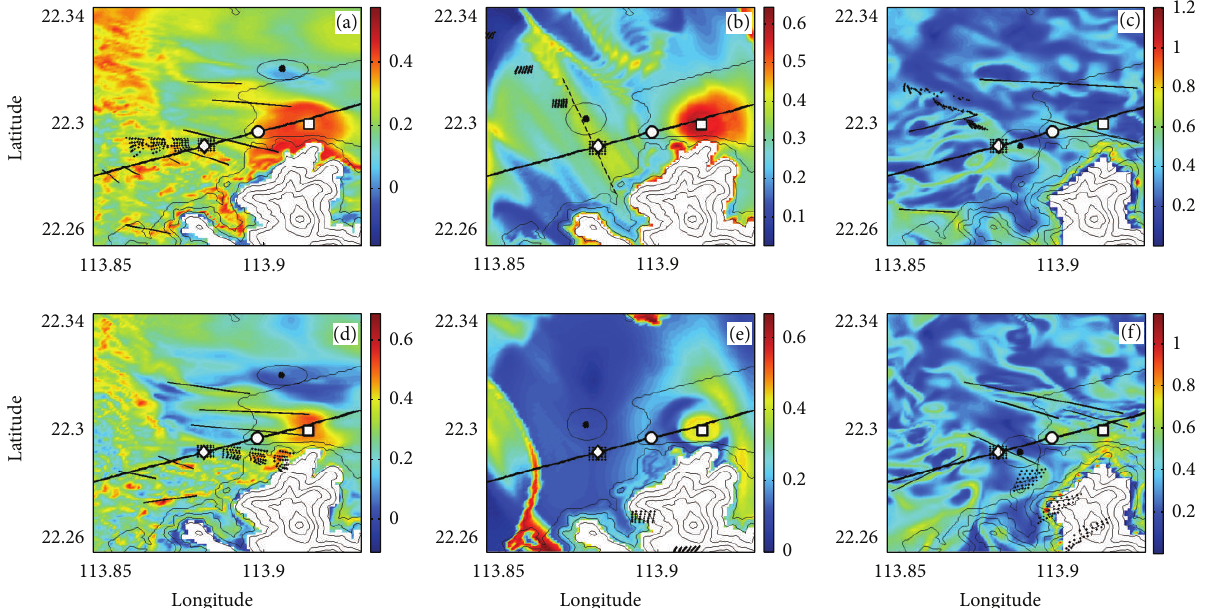
Figure 3: FTLE fields interpolated on the LIDAR scanning cone. The panels are, from left to right, data from RAMS, FLOWSTAR, and WRF, respectively. The top panels are the forward time FTLE and the bottom panels are the backward time FTLE. The black straight lines mark locations of great similarity in FTLE with Figure 4, and the black circles mark locations of a few mismatches with Figure 4.